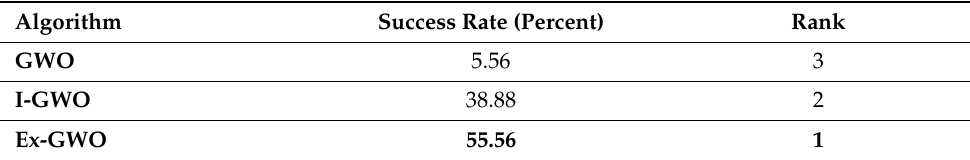
Table 3. Ranking summary of metaheuristic algorithms in cost